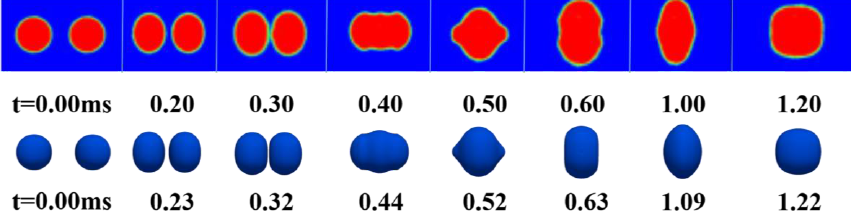
Figure 6. Numerical verification of water droplet collision in the oil phase: the simulation results of Yuan [16] ( top ); the numerical simulation results of this model ( bottom ).